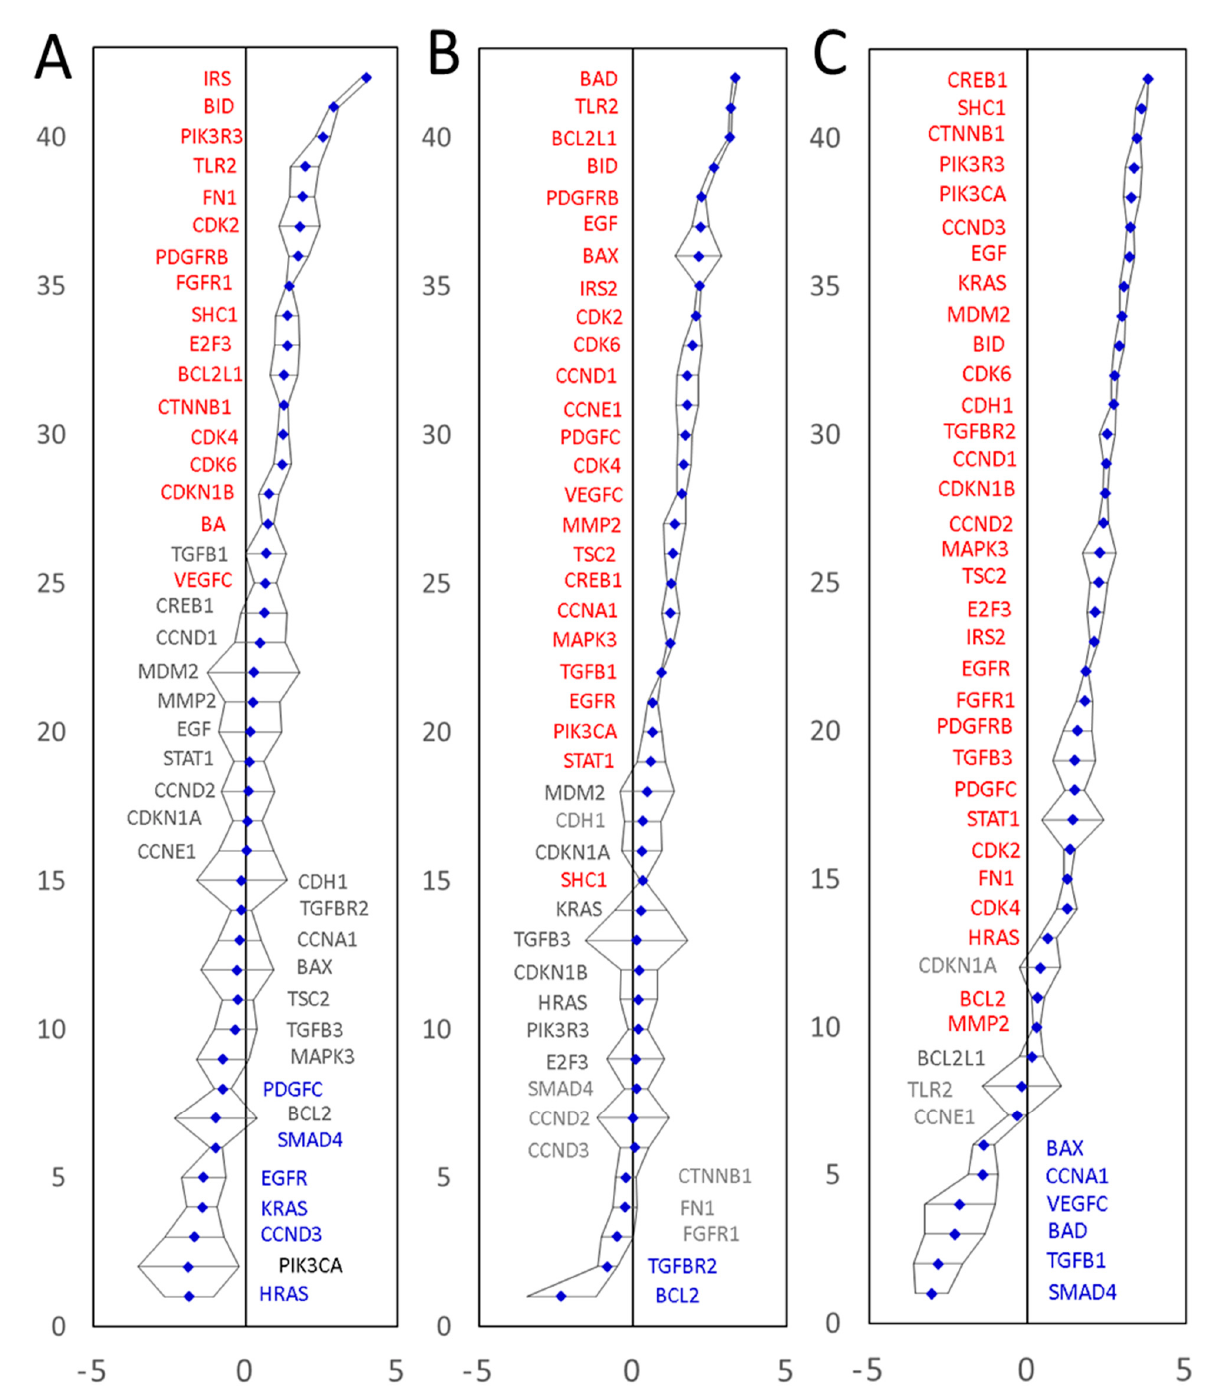
Figure 5. Experimental validation of differential expression of the predicted CRC marker genes in three patients using qPCR. The expression values on a Log(2) scale are shown. Panel ( A ): moderately differentiated adenocarcinoma of the sigmoid colon, T2N0M0, EMVI negative. Panel ( B ): A moderately differentiated adenocarcinoma of the sigmoid colon, T4N2M0, EMVI positive. Panel ( C ): A moderately differentiated adenocarcinoma of the caecum, T3N1M0, EMVI negative. All amplifications were performed in triplicate. Confidence intervals ( p = 0.05) are shown as black error bars. Expression values were normalized to the endogenous levels of three reference RNAs (GAPDH mRNA, 18S and 28S rRNAs). Significantly upregulated genes are labelled in red and significantly downregulated genes are shown in blue.